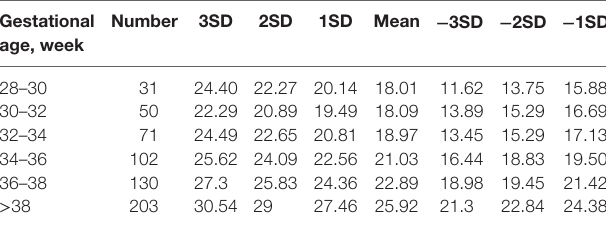
TaBle 1 | Mean and SD of penile length based on different gestational age of neonates. gestational number age, week